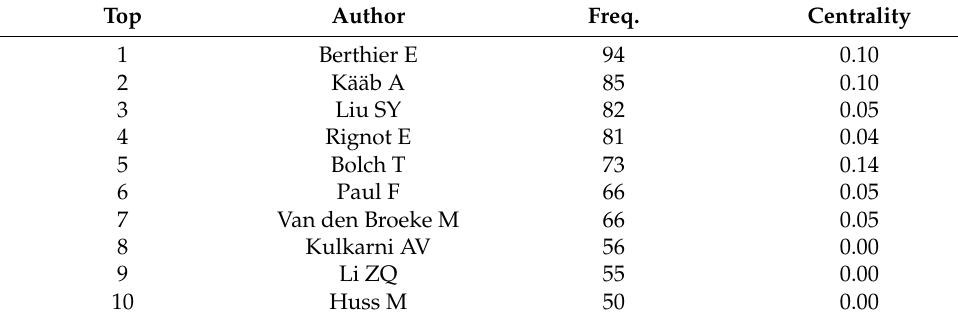
Table 3. Top 10 authors based on